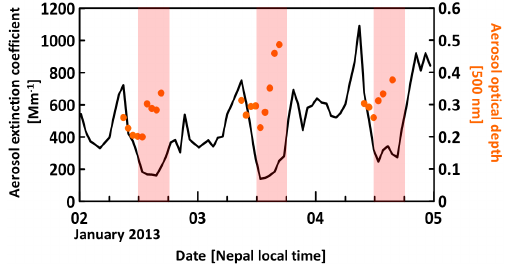
Figure 8. Variation in surface aerosol extinction coefficient (550nm) and column aerosol optical depth (500nm) at the Bode site from 2 to 4 January 2013.